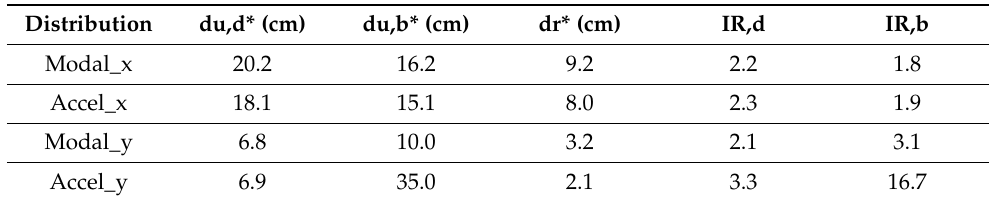
Table 5. Safety indices in the post-intervention phase.